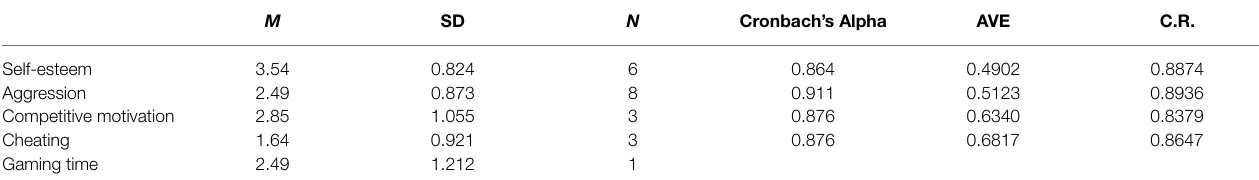
TABLE 1 | Reliability and discriminant validity of constructs. M SD N